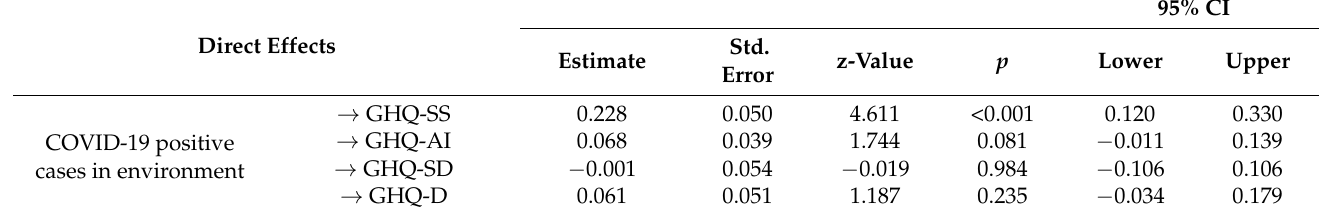
Table 3. Direct, indirect, and total